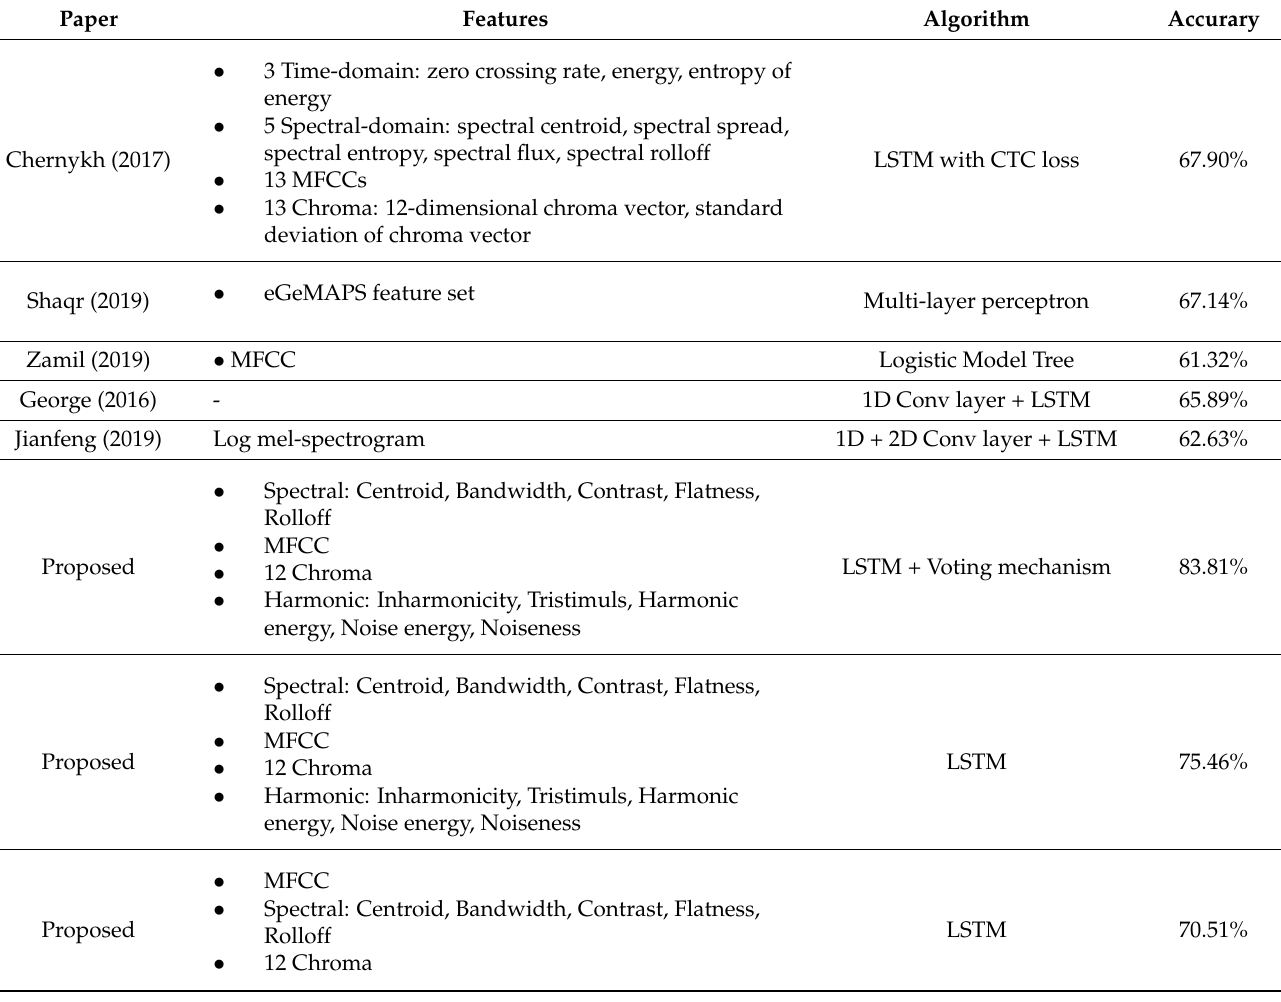
Table 3. Experimental results from